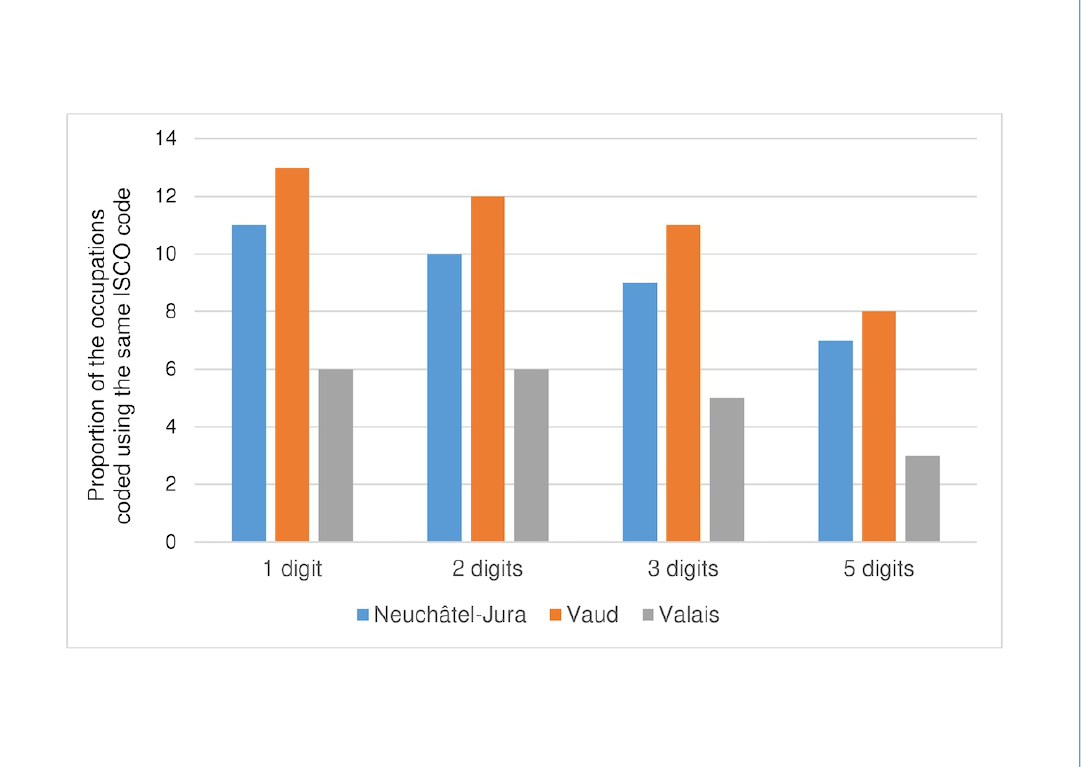
Figure S1: Proportions of the occupations coded using the same International standard classification of occupations (ISCO) code as in the Swiss National Cohort between 1996 and